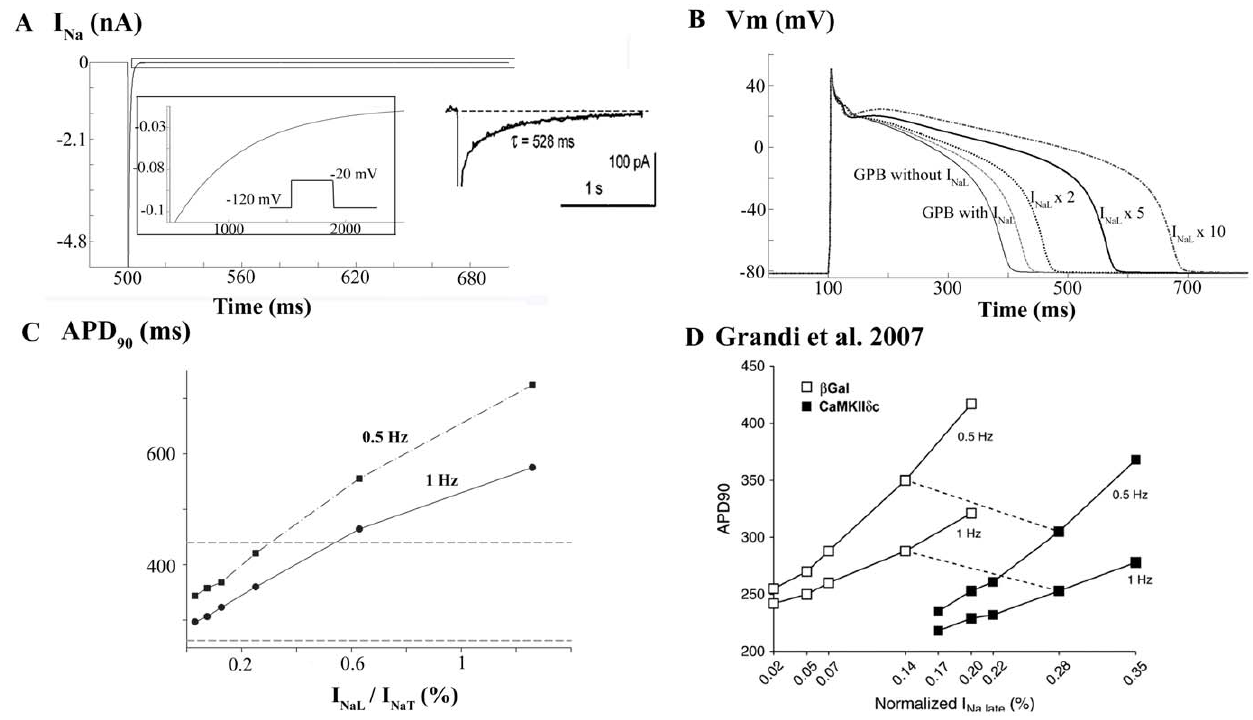
Figure 1. Time course of late Na + current and its effects on AP. A: Simulation of late Na + current (I NaL ) using a voltage clamp protocol similar to that of the experimental measurements obtained by Maltsev et al. [26] (shown in the right inset) in ventricular myocytes at room temperature. The left inset shows an expanded view of the current between 480 ms and 2500 ms. B: Simulated action potentials (APs) at 1-Hz pacing rate using the GPB model, the GPB model modified with control I NaL , and I NaL enhanced 2-fold, 5-fold and 10-fold. C: APD 90 sensitivity to the I NaL amplitude. APs were simulated at 0.5-Hz (square symbols) and 1-Hz (circle symbols) pacing rate by varying I NaL /I NaT ratio from 0.0298% to 1.26%. The range of experimental APD at 90% repolarization (APD 90 ) for human is represented by the two discontinuous lines. D: APD 90 sensitivity to the I NaL amplitude (open symbols) taken from Grandi et al. [30] who used a rabbit model.